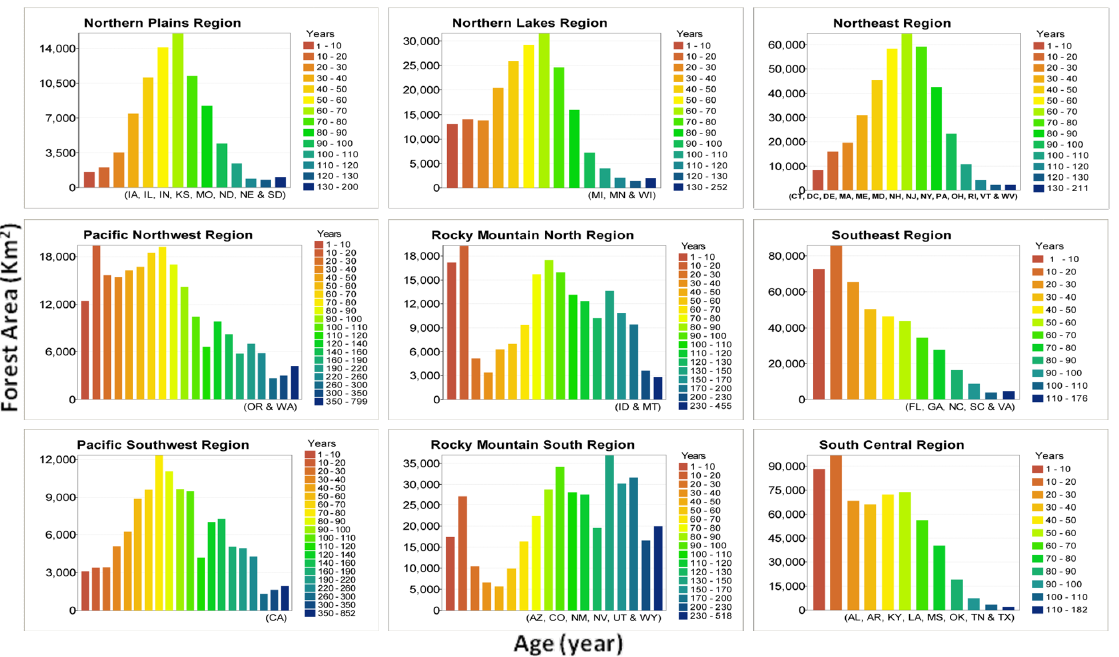
Figure 4. The forest age distributions in different regions of Continental US (the histograms are placed in this figure as much as possible corresponding to their geographical positions).